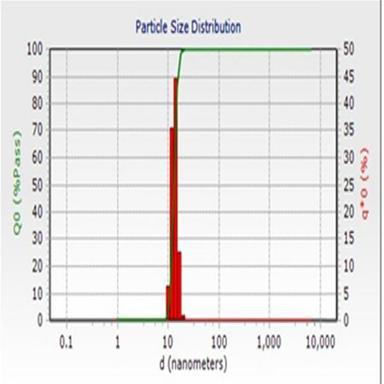
DLS curve for nanocellulose of wheat straw.